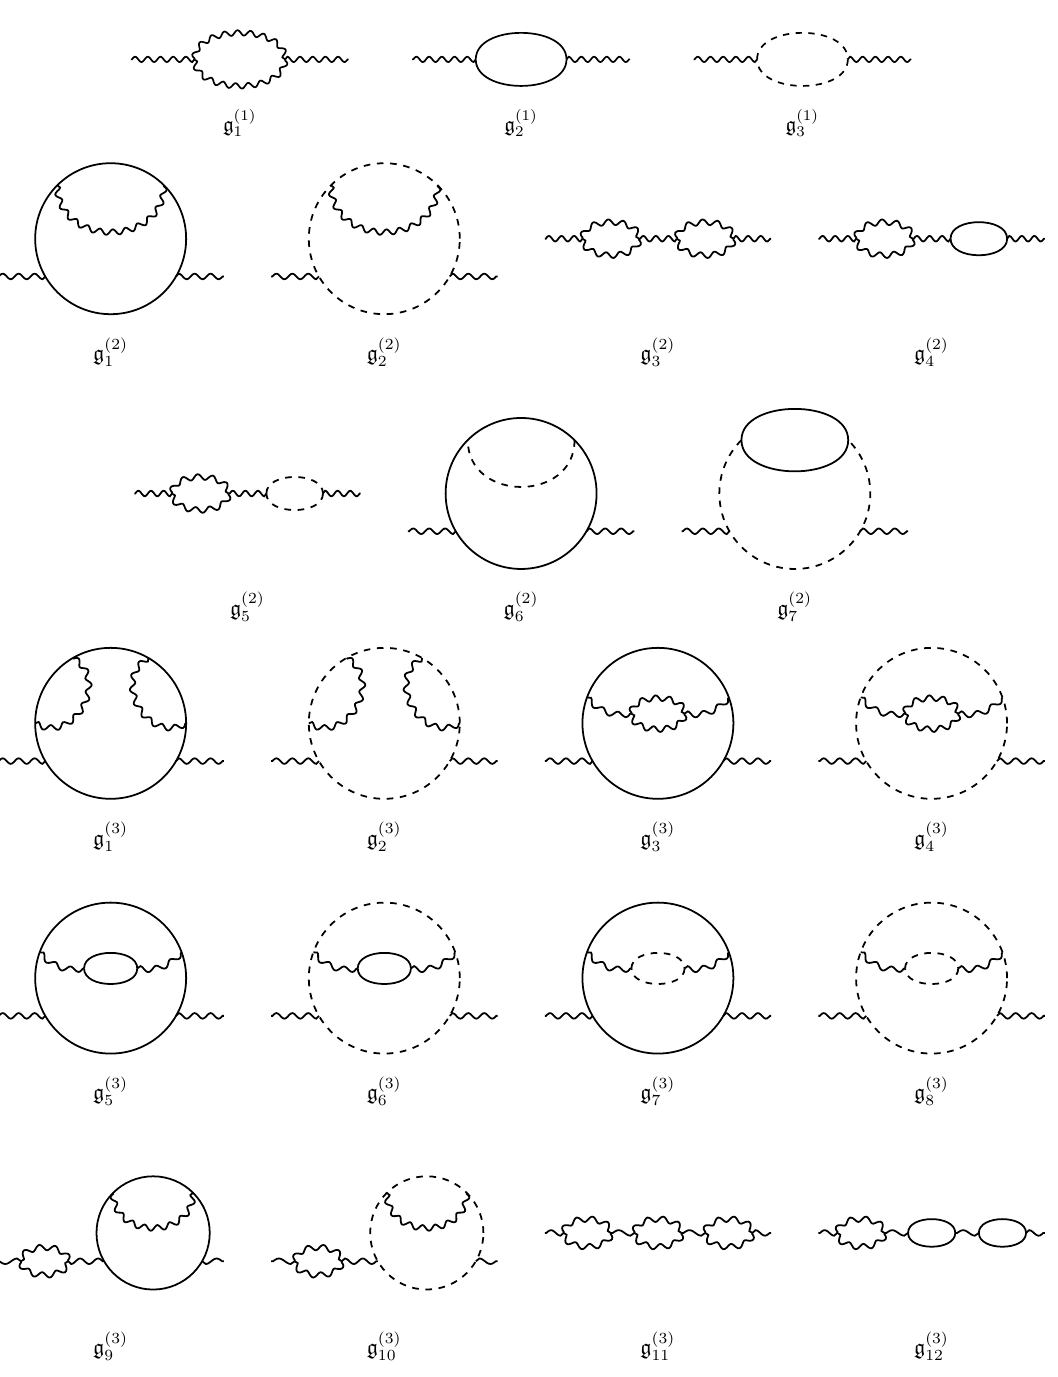
Figure 1 . Graph representation of the TSs appearing in the gauge (cid:12) -function, (cid:12) ( ‘ ) orders. Recall that the external lines do not carry powers of the gauge